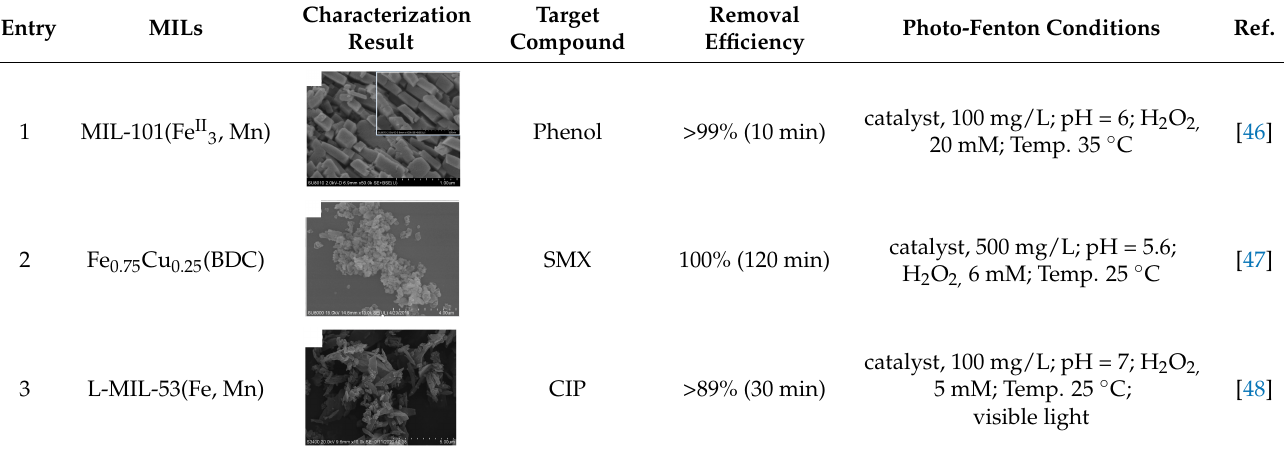
Table 2. Summary of modified MILs and their degrading information in the Fenton system. Table 2. Summary of modi fi ed MILs and their degrading information in the Fenton system. Table 2. Summary of modi fi ed MILs and their degrading information in the Fenton system. Table 2. Summary of modi fi ed MILs and their degrading information in the Fenton